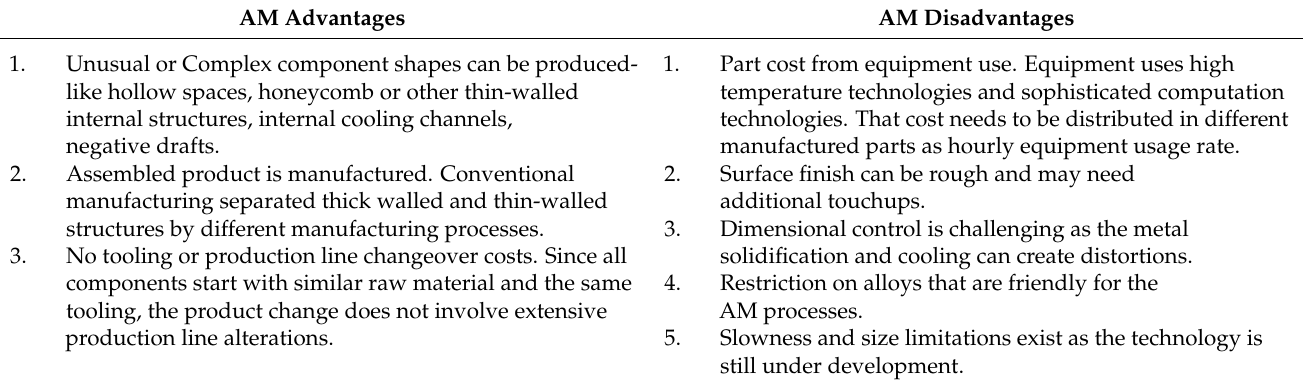
Table 1. Advantages and disadvantages of AM as listed by a manufacturer